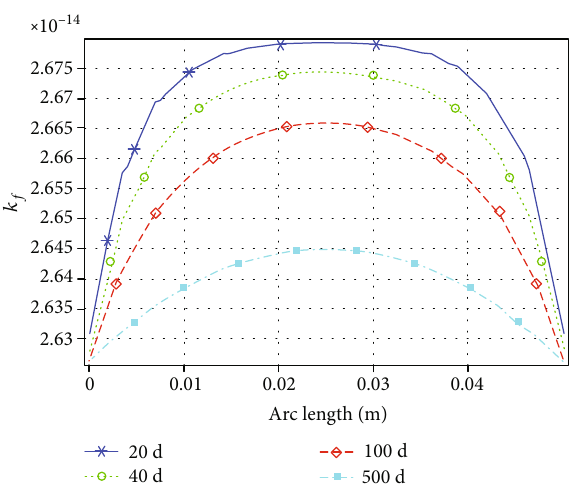
Figure 8: Evolution of permeability in the upper boundary pore